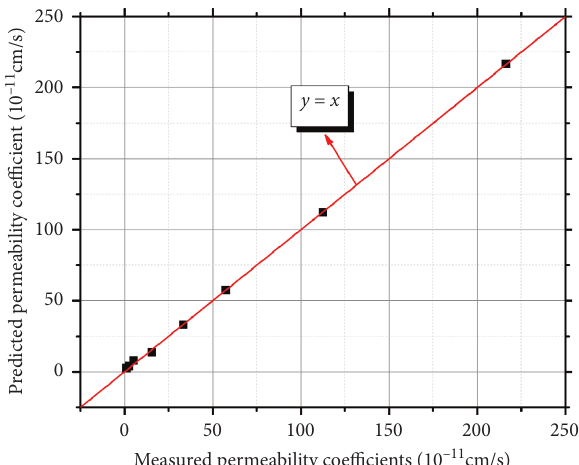
Figure 9: Comparison of the predicted and measured permeability coefficients.